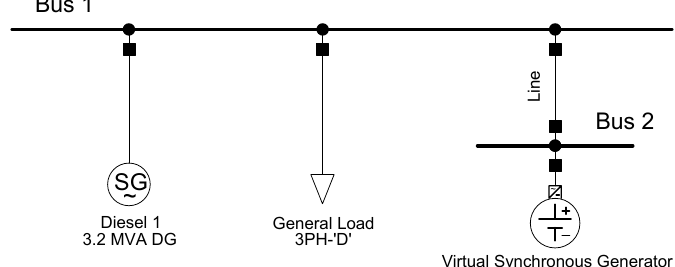
Figure 6. System overview diagram of SMSIB system in test case. Table 2. Parameters for SMSIB